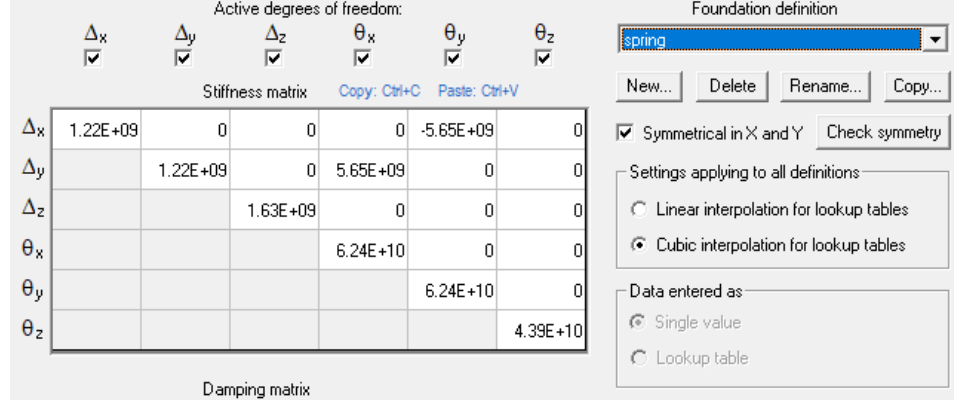
Figure 7. Bladed input for stiffness of foundation spring.